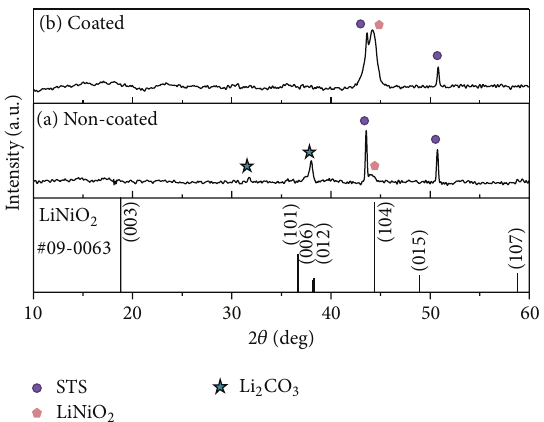
Figure 5: XRD patterns of (a) noncoated and (b) ZrO 2 -coated LiNiO 2 thin films. The films were annealed in 10min at 500 ∘ C.